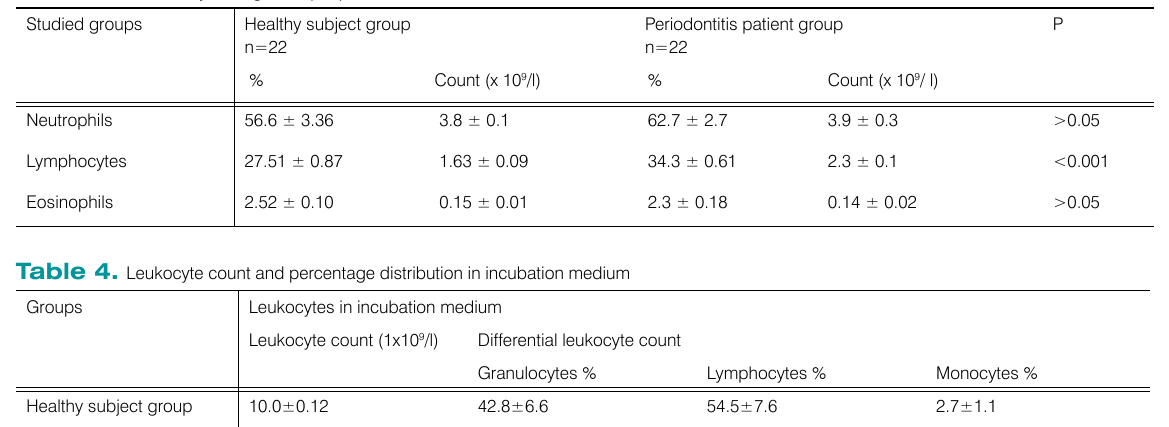
Table 3. Laboratory testing data, peripheral blood.